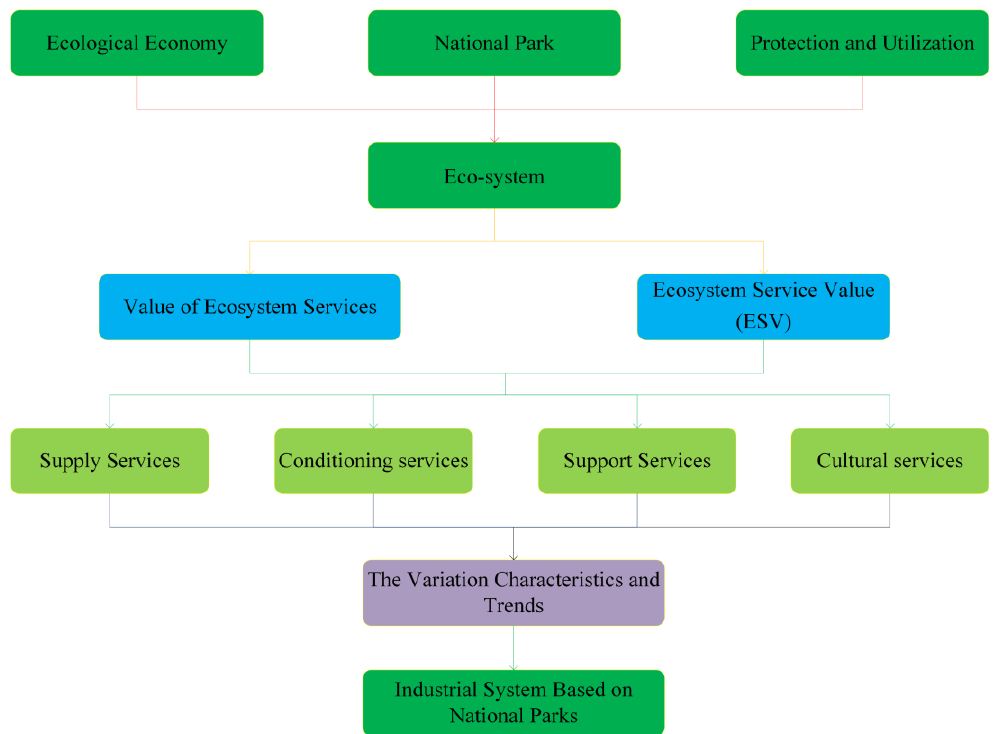
Figure 2. Flow chart. Based on the background of the construction of a community with a shared future for man and nature with Chinese characteristics, relying on the construction of the main body of national parks, highlighting the relationship between ecological economic development and ecosystem protection and utilization, calculating the value of ecosystem services through the equivalent factor of ecosystem services, maximizing the benefits of the four major ecosystem service functions of supply, regulation, support and culture, and analyzing the changing characteristics and trends of the four, and then putting forward countermeasures and suggestions for the construction